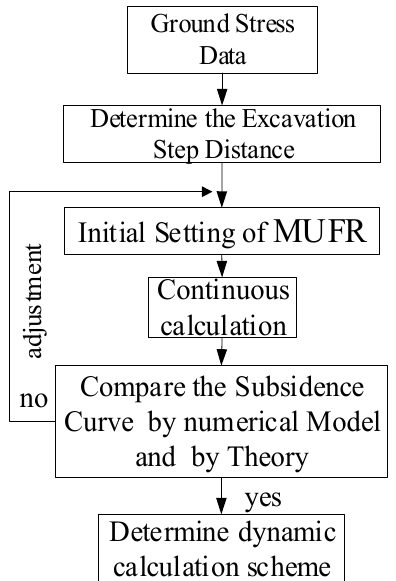
Figure 9. The dynamic calculation scheme.